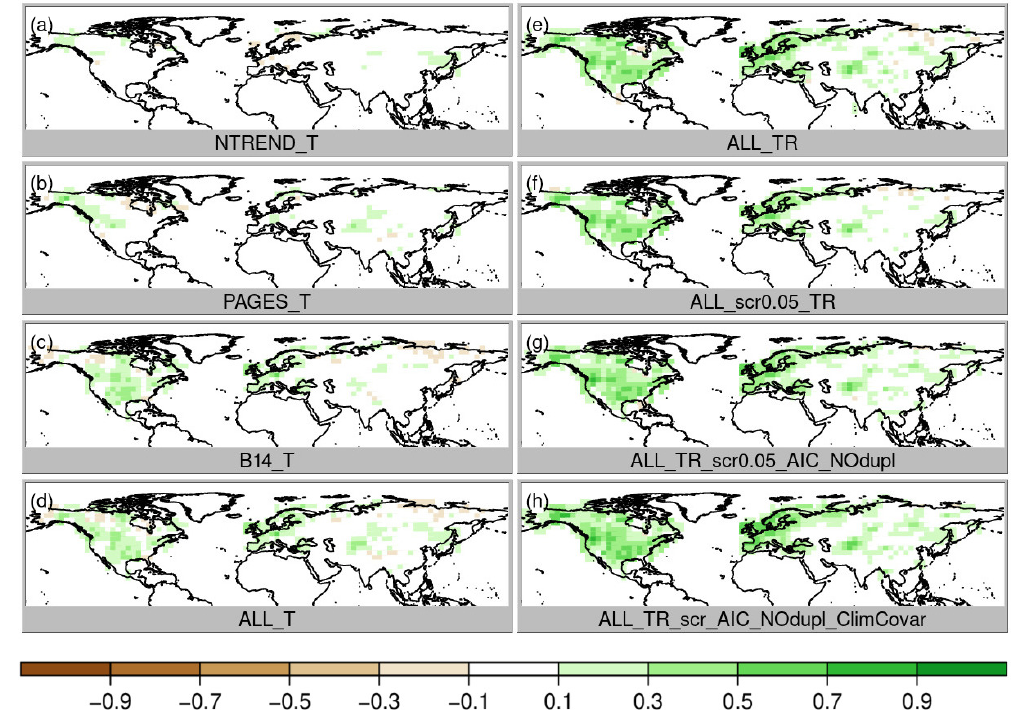
Figure 4. Same as Fig. 3 for precipitation correlation, where green colors indicate an improvement of the